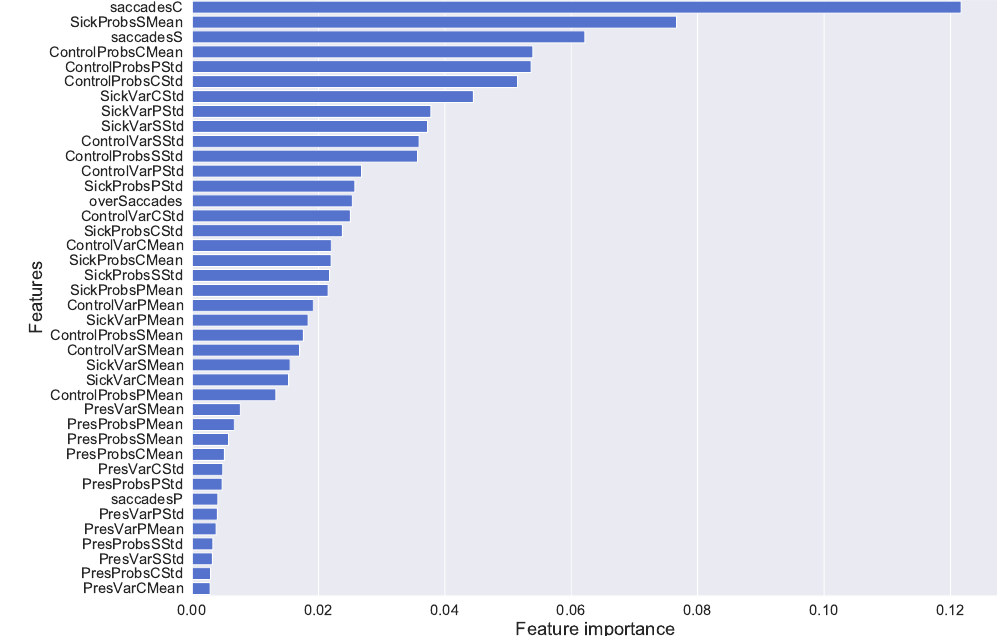
Figure 7. Importance of the features as derived from Gini impurity.